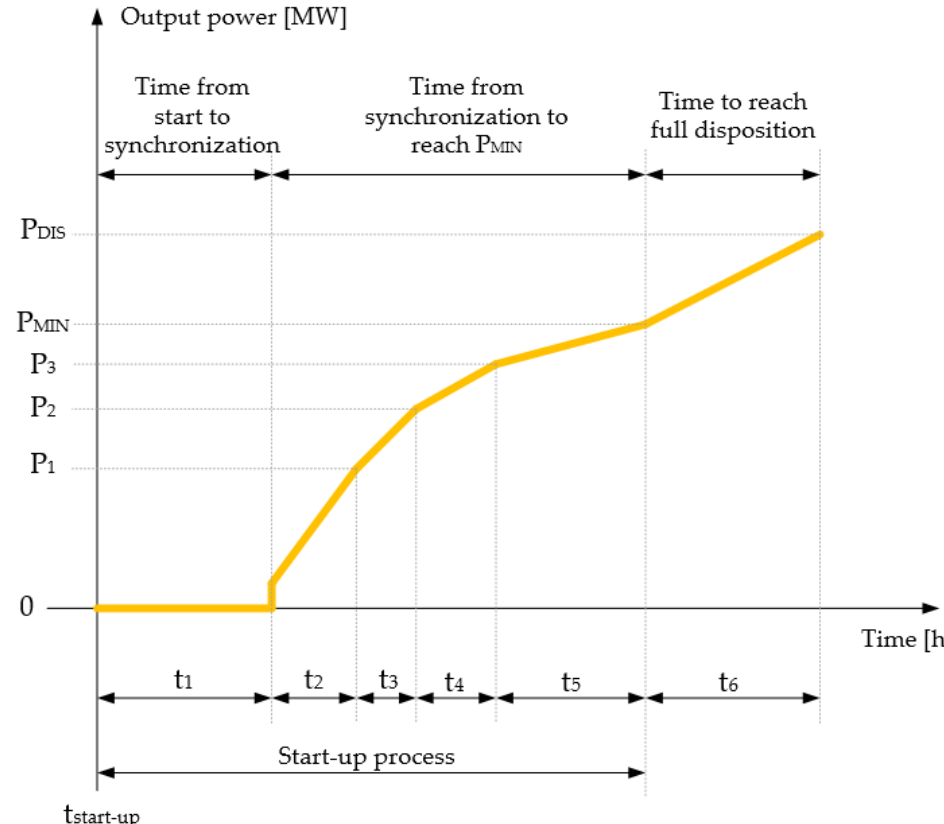
Figure 2. An example of the start-up characteristic, where: tstart-up—the time point when the start-up begins; t 1 –t 6 —characteristic times related to the warming up processes; P 1 –P 3 —characteristic values of output power related to the warming up processes; PMIN—minimum technical output power after start-up process; PDIS—minimum output power available for the system operator taking into account power reserved for the provision of the additional services. Own development based on [26,27].